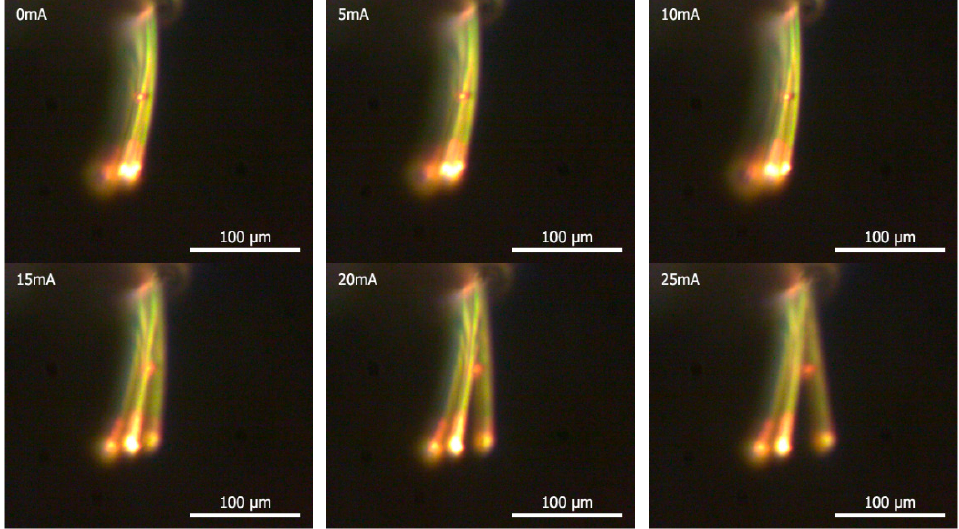
Figure 11. Flexural motions of bimorph microcantilevers thermally activated by electrical current (0–25 mA).